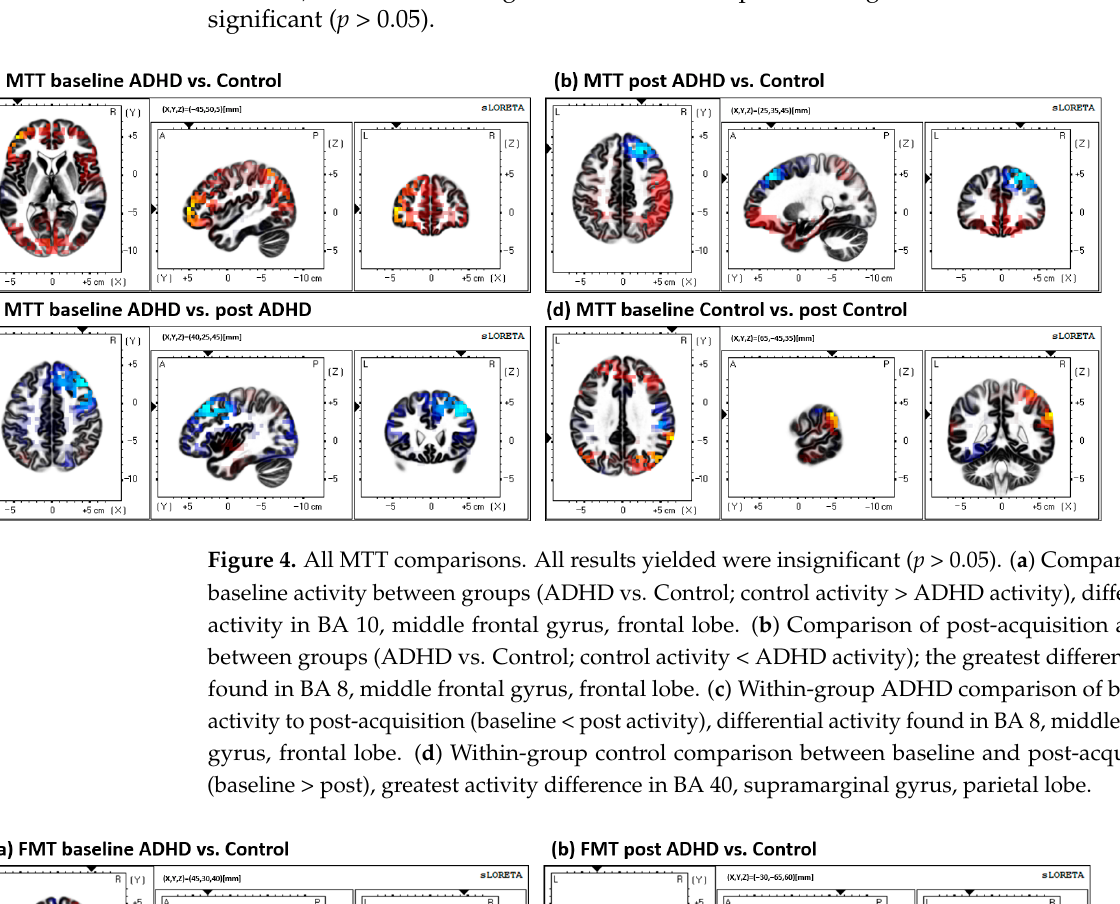
Figure 3. Sources of neural activity in those with ADHD at baseline (pre) measures and at post- measures after participants completed the FMT. Latency coincides with the differential image cre- ated using sLORETA (Figure 1). Cross-sectional areas include the coronal (left), transverse (middle), and sagittal plane (right).